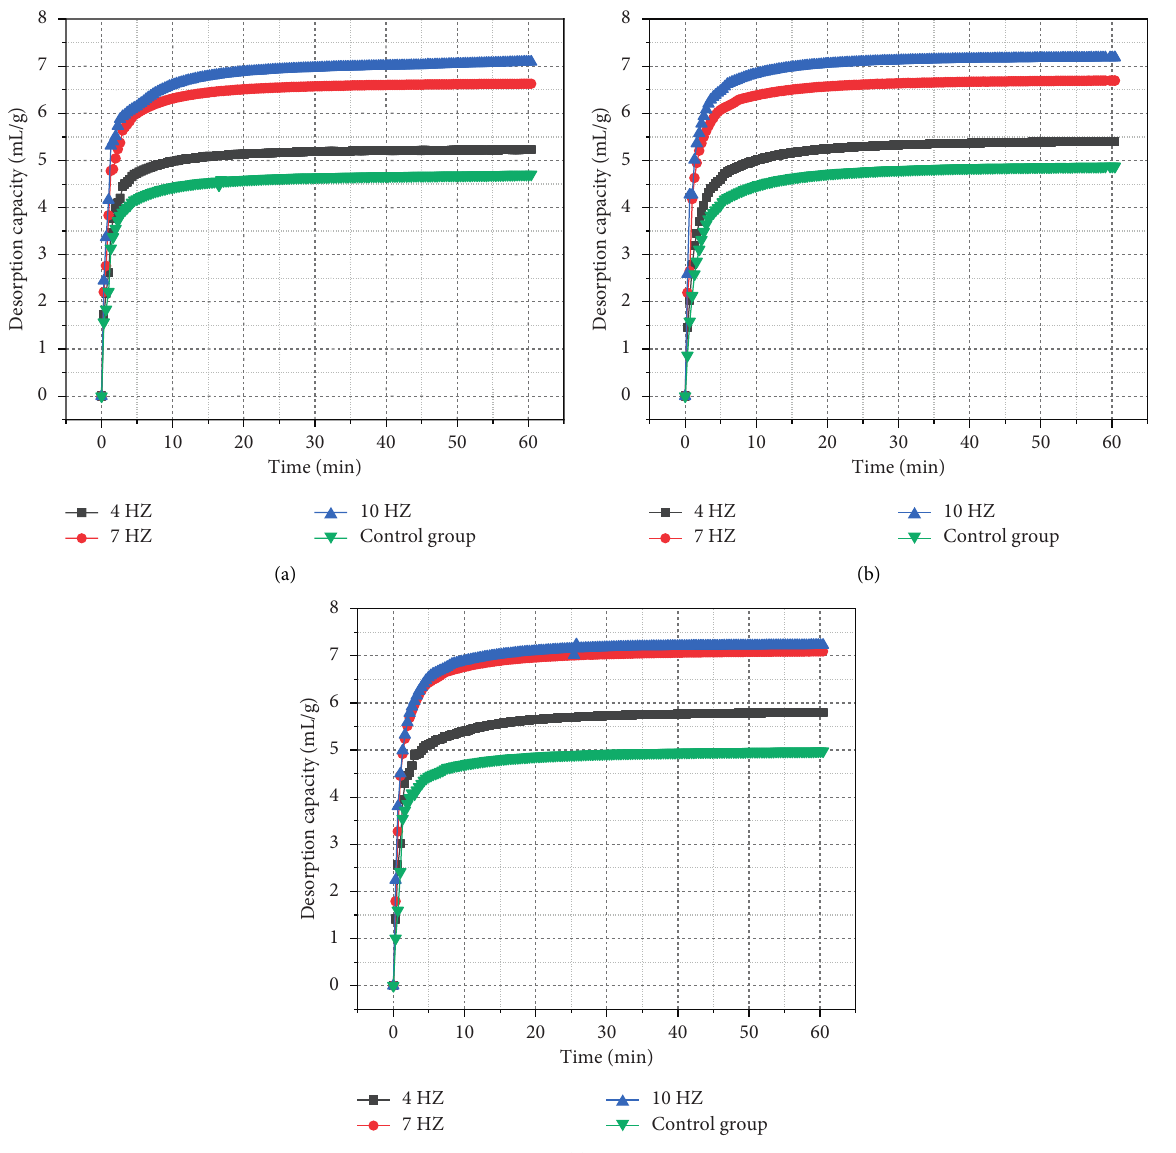
Figure 2: Desorption curves of the samples under different loading frequencies. (a) Equilibrium pressure of 0.5MPa. (b) Equilibrium pressure of 1.0 MPa. (c) Equilibrium pressure of